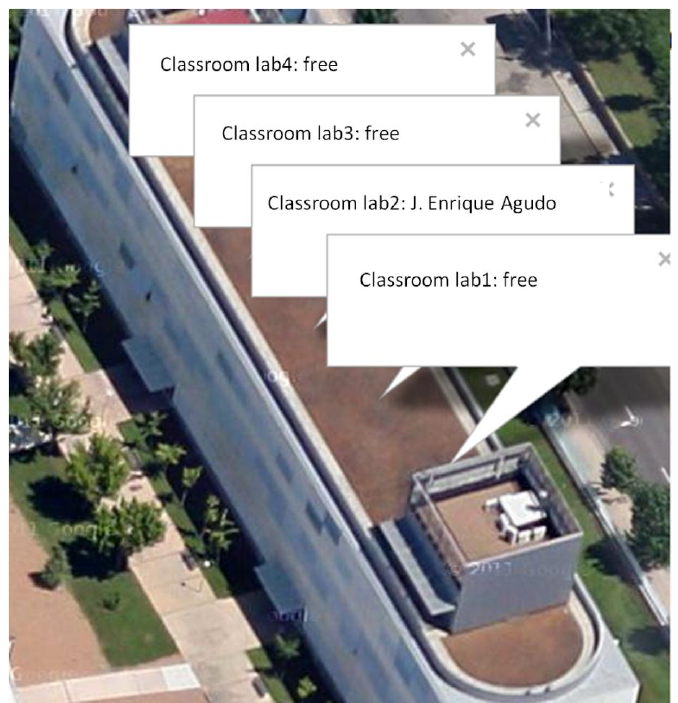
Figure 9. Data in the